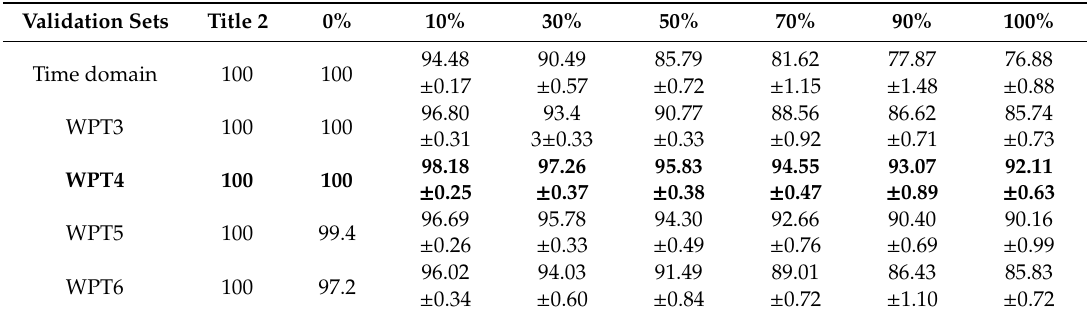
Table 6. Experimental results for the effects of the WPT level on the accuracy and noise resistance of the algorithm. Validation